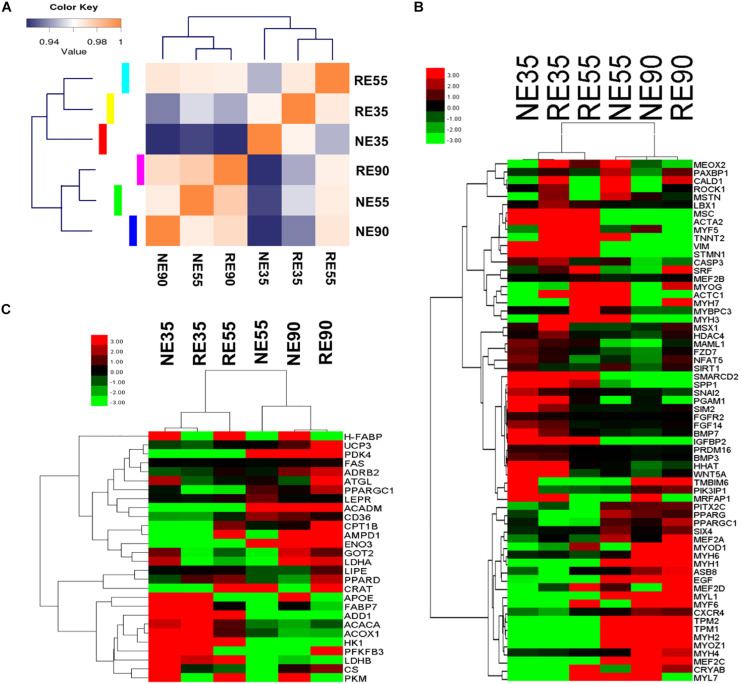
Whole genome expression characterization of the effect of MCR on muscle development. (A) Sample correlation matrix indicates the influence of MCR on gene expression patterns. (B) Influence of MCR on expression profiling of myofiber development genes. (C) Influence of MCR on expression profiling of metabolic type-related genes. NE35, NE55, and NE90 indicate samples collected from NE group at 35, 55, and 90 dg, respectively, RE35, RE55, and RE90 indicate samples collected from RE group at 35, 55, and 90 dg, respectively.